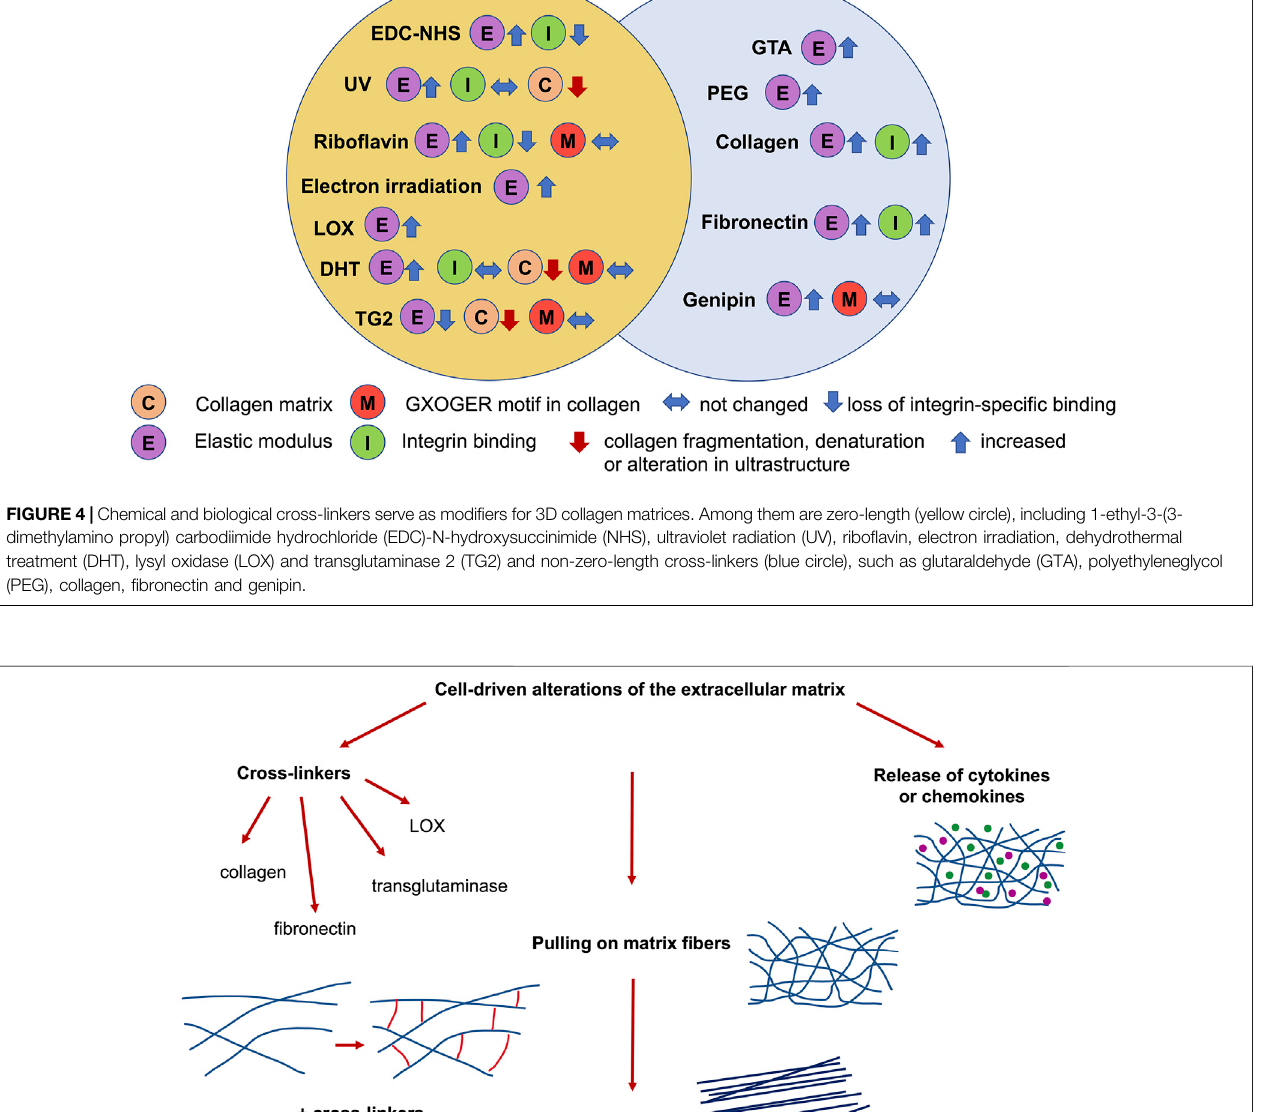
Frontiers in Physics |